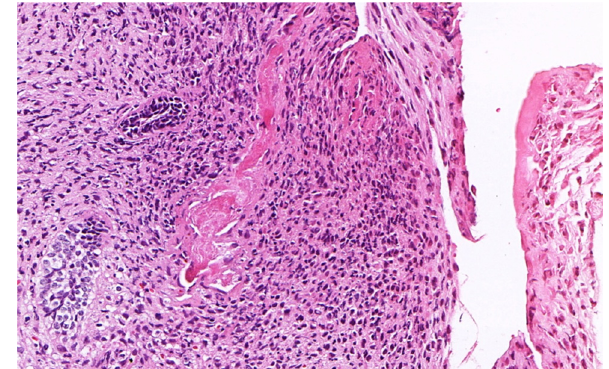
Histopathological aspects showing deposition of dentinoid-like material. (H&E stain, 200 ×